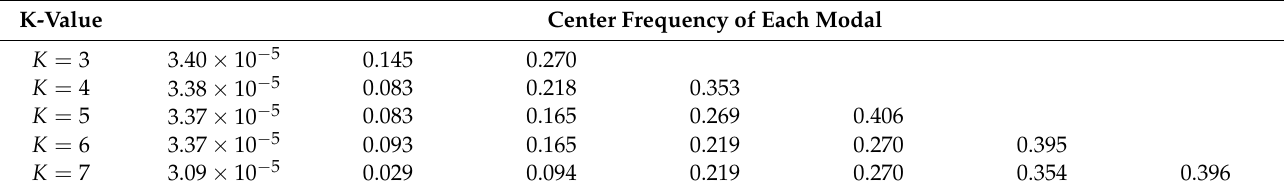
Table 2. Center frequency of each modal in dataset A.